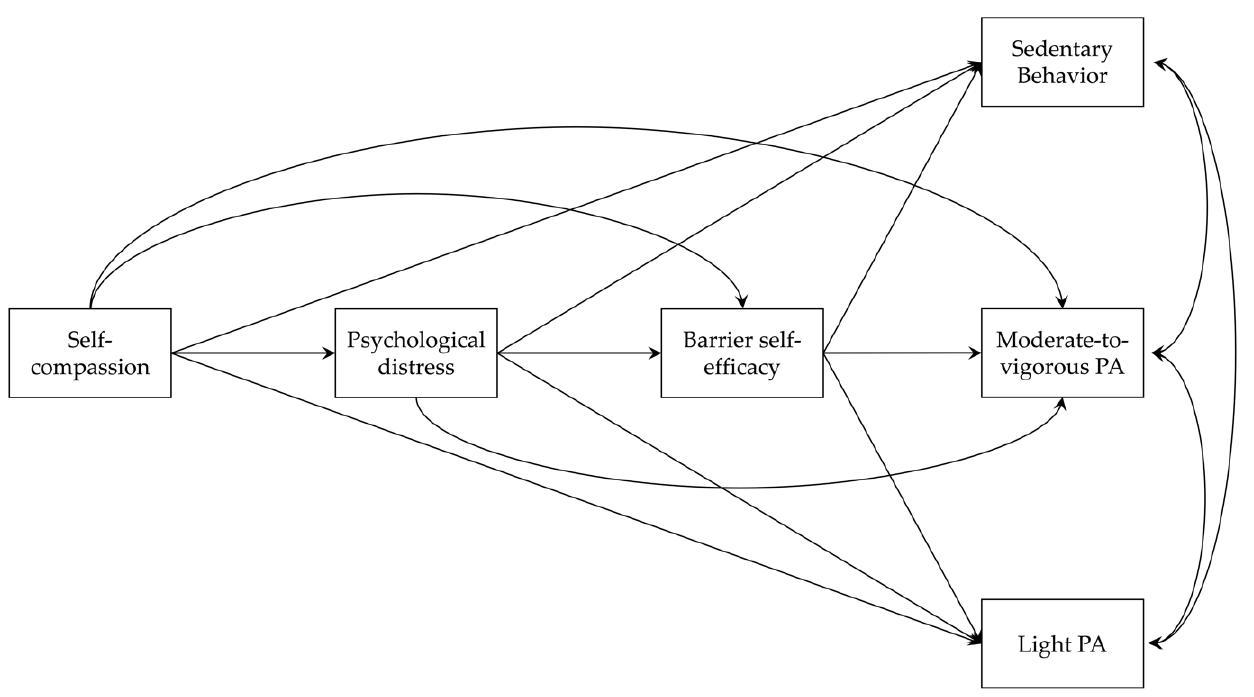
Figure 1. An illustration of the conceptualised multi-mediator multi-outcome model examining the direct and indirect effects of self-compassion on sedentary behaviour, light physical activity (PA), and moderate-to-vigorous PA via reduced psychological distress and increased barrier self-efficacy. Each uni-directional, arrowed path represents a direct conceptual effect, whilst each bi-directional path represents the synchronous correlation of a pair of study outcomes.